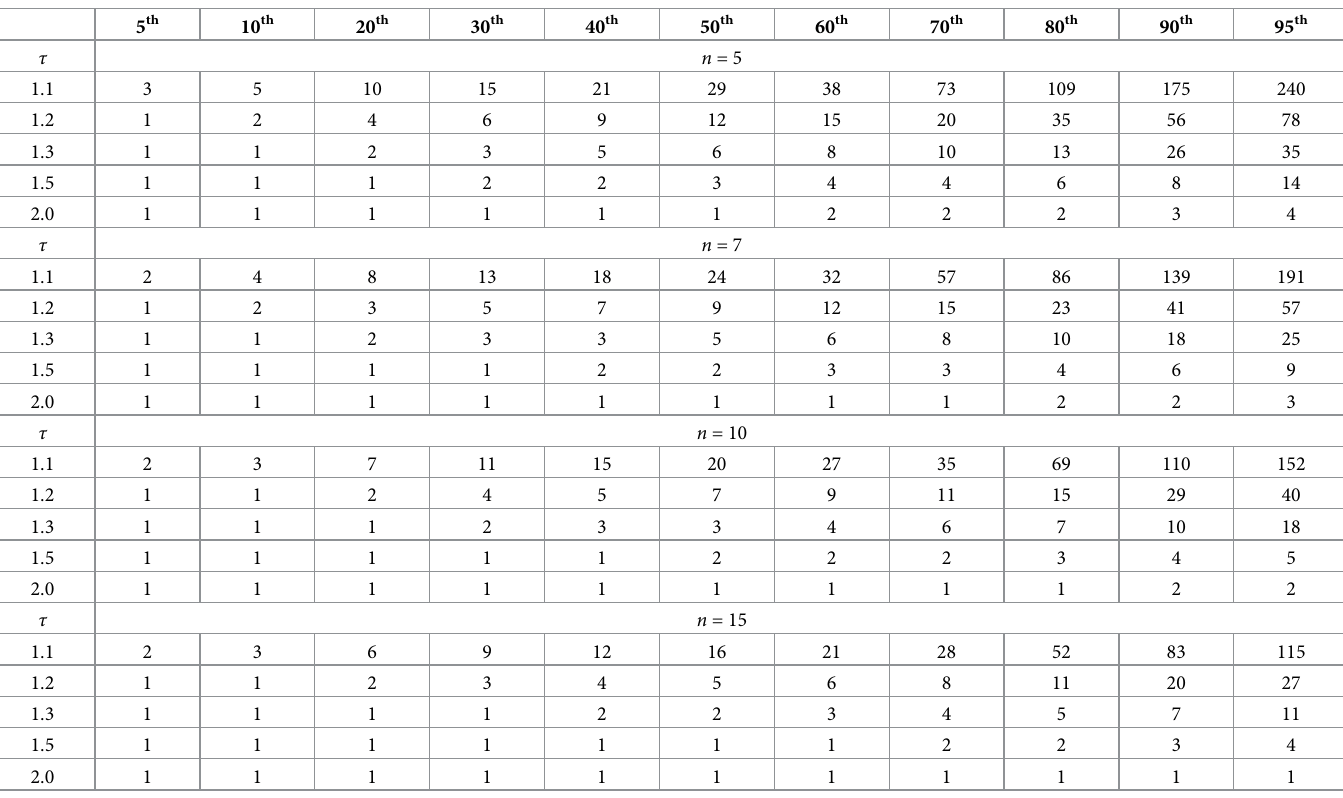
Table 3. Out-of-control percentiles of the run length distribution for the ARL -based side sensitive synthetic- γ chart for γ 0 = 0.05, n 2 {5,7,10,15} and τ 2